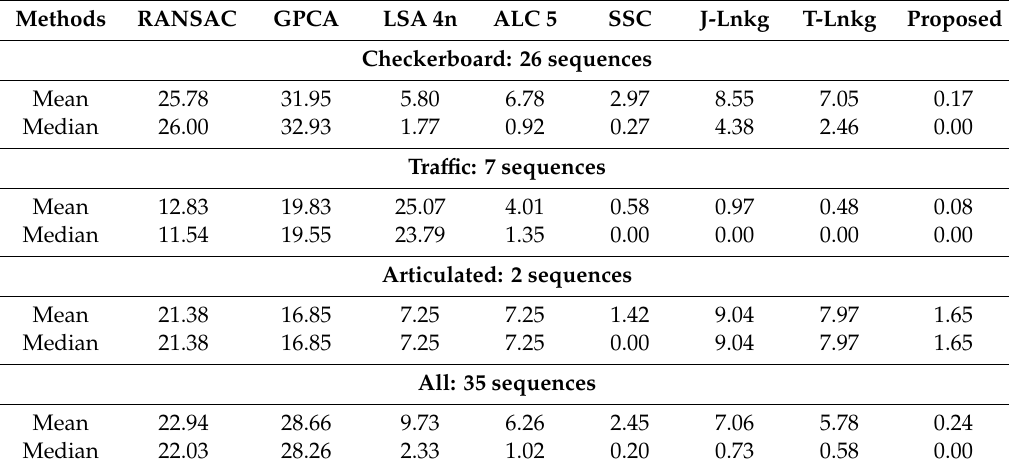
Table 1. Classification errors (%) for sequences with three motions.